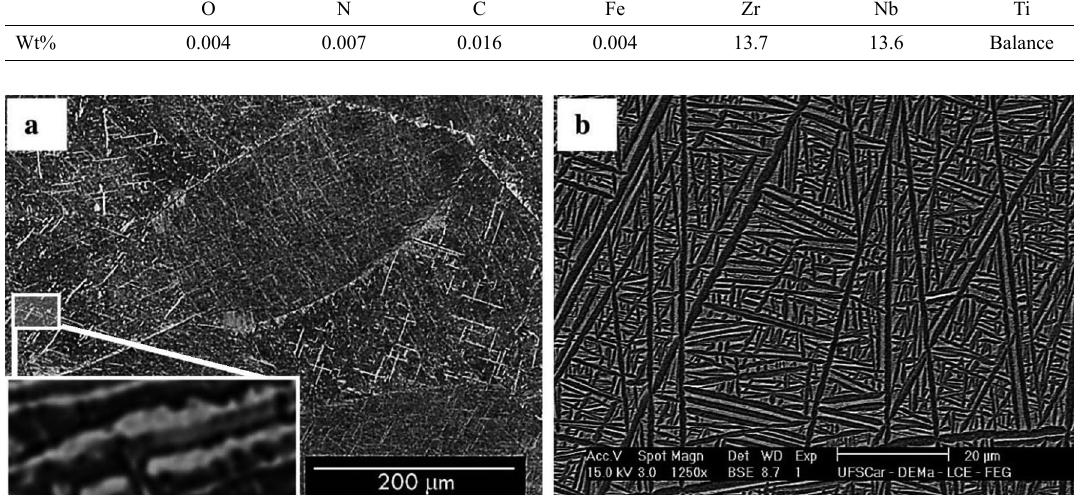
Figure 1. Micrographs showing the microstructure of Ti–13Nb–13Zr alloy in the initial state: a) OM, where the white needle-like microstructure is the α-phase embedded in the dark grains of β-phase. b) SEM.